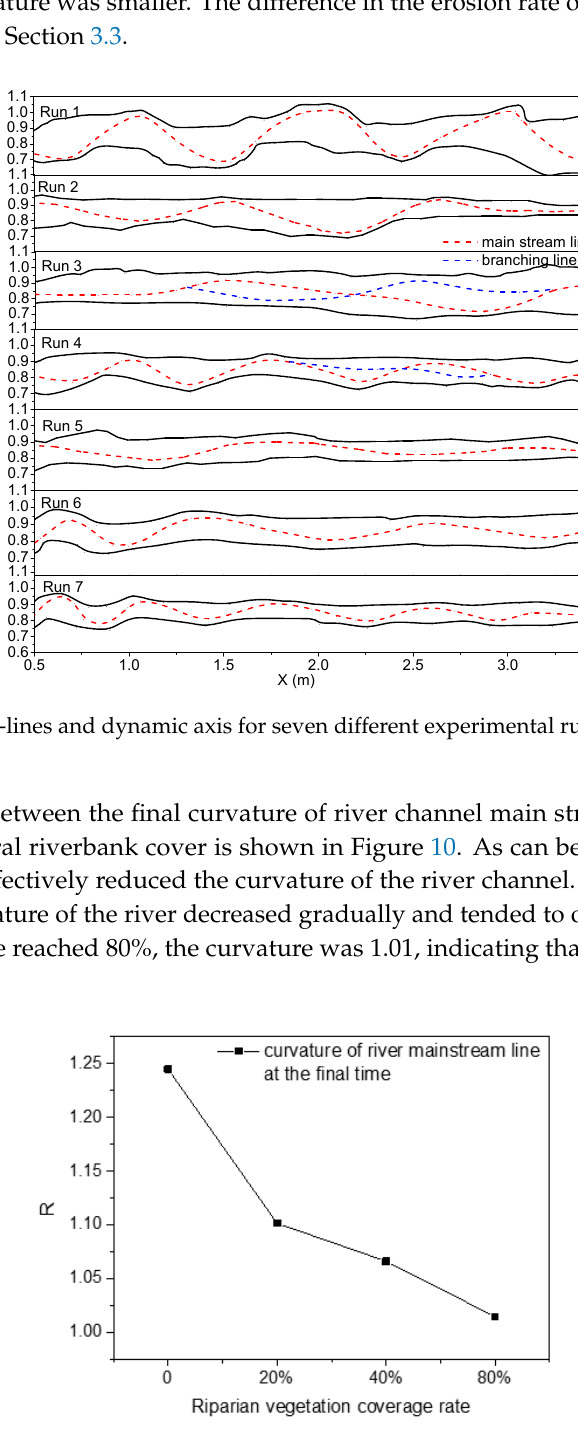
Figure 10. Relationship between river channel curvature and riparian vegetation coverage rate of bilateral cover.